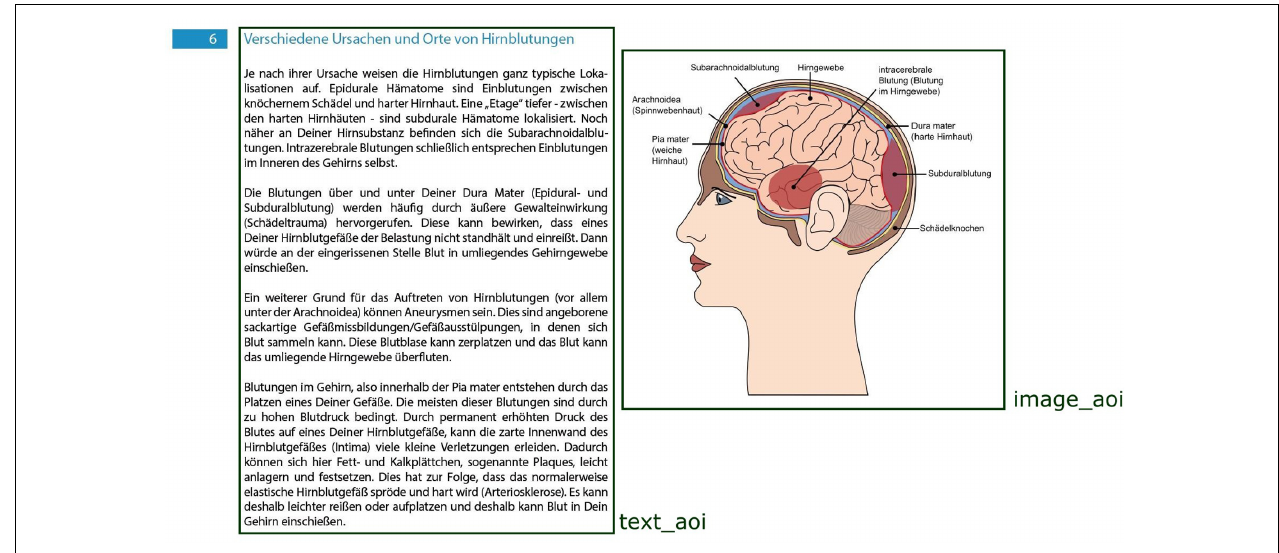
FIGURE 1 | Predefined AOIs based on